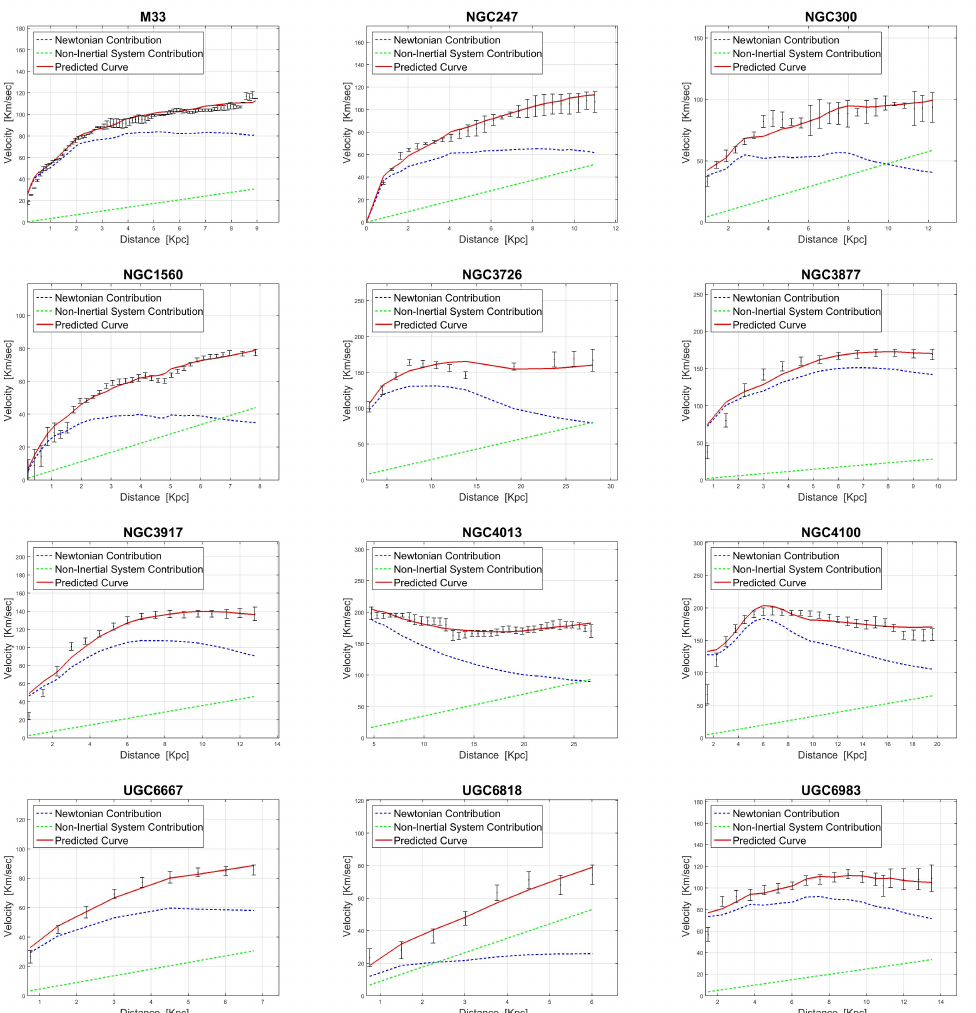
Figure A2. RCs for the different galaxies are presented. In each panel one can see the measured values (black error bars) together with the predicted curve (red line). The dashed blue curve corresponds to the Newtonian term v k ( r ) while the dashed green line corresponds to the linear correction term ω r